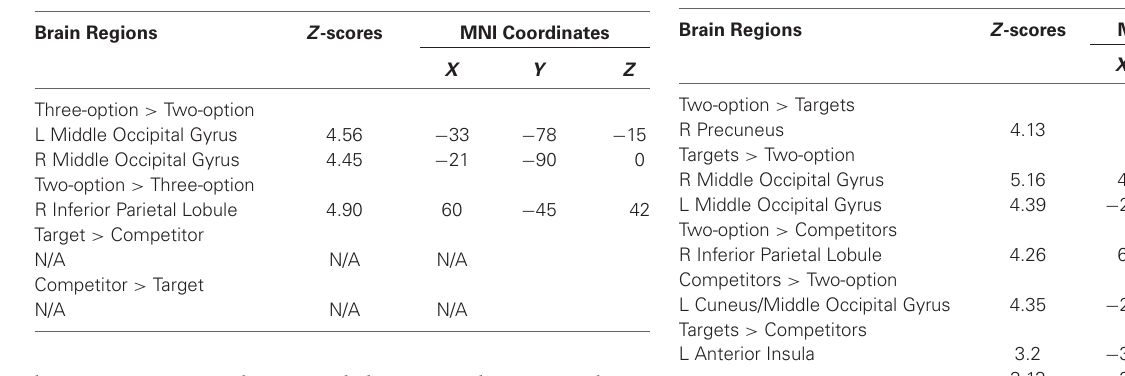
Table 1 | Brain activation at the stimulus phase . Table 2 | Brain activation at the decision phase